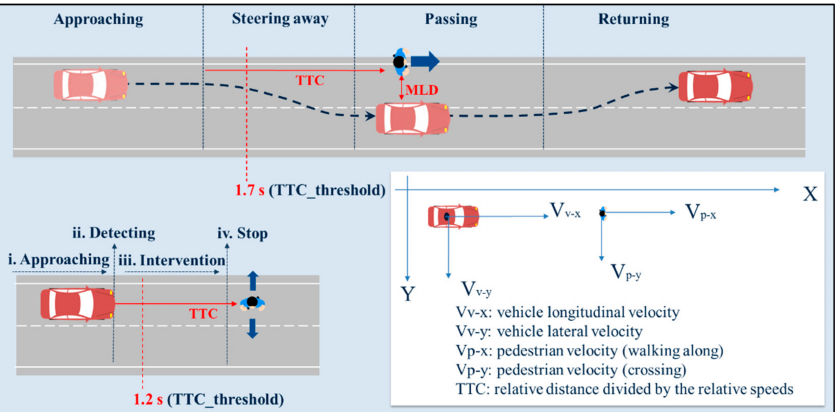
Figure 6. Example scenarios of potential AV-VRU interactions on highways and the effectiveness of active safety systems. ( Top ) VRU overtaking for safety evaluation of Automatic Emergency Steering systems. ( Bottom ) VRU collision avoidance for safety evaluation of Automatic Emergency Braking systems. TTC represents the remaining time before AV strikes VRU if they continue to travel with the same speed and